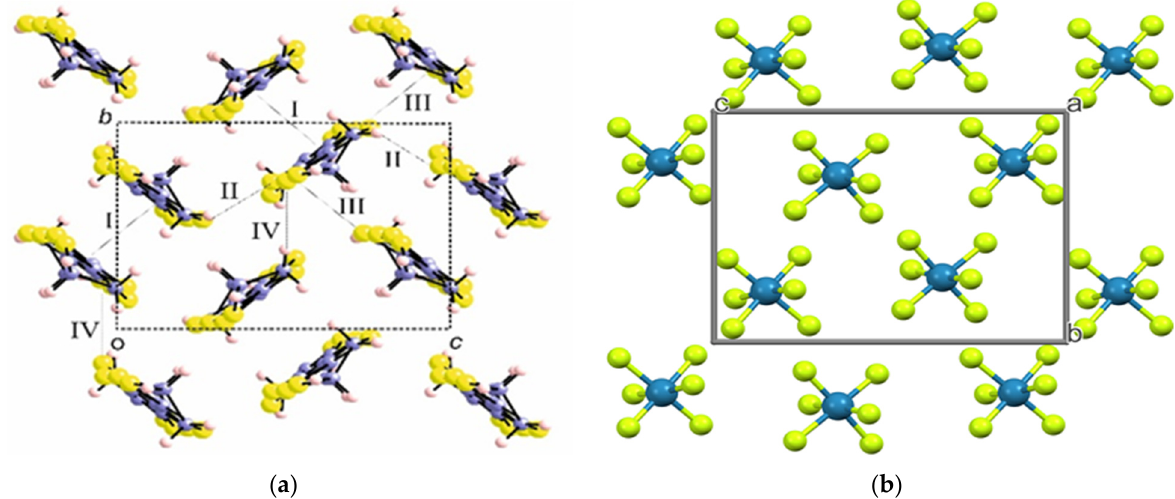
Figure 2. Projections of: ( a ) the radical cation layer, where the different intermolecular interactions are labeled and ( b ) the anionic layer along the a axis in the κ -(BDH-TTP) 4 ReF 6 ( 1 ) salt. Table 1. Short intermolecular contacts in the structure of the salt 1 . Symmetry Operation for the 1st Short Contact Contact Length, Å Atom in Contact